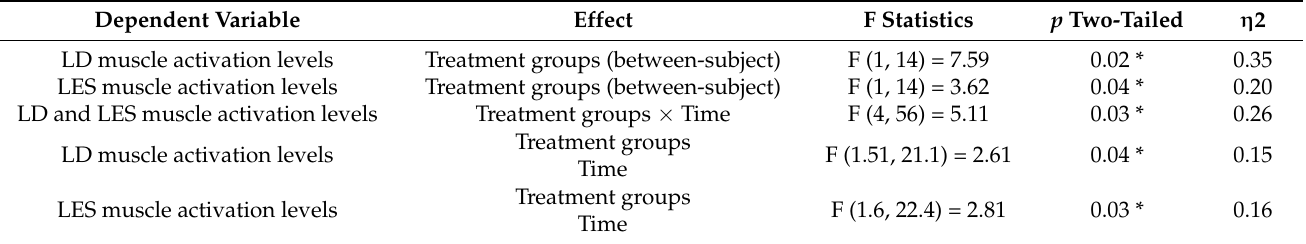
Table 9. Mixed-design repeated measures ANOVA test results with the forward bending posture (45 ◦ downward extension).